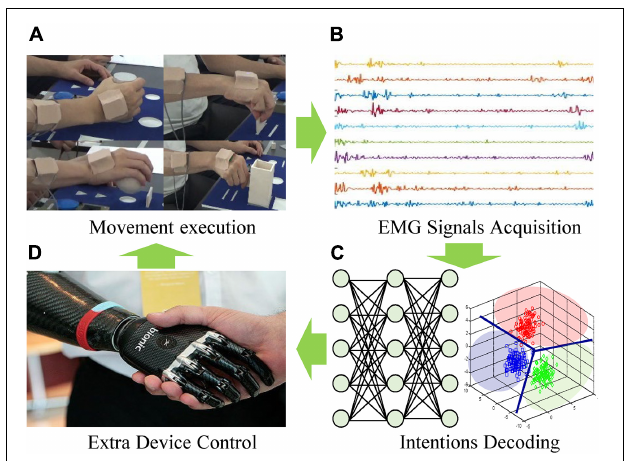
FIGURE 1 | Overview of myoelectric interfaces. (A) Movement excution. (B) EMG signals acquisition. (C) Intentions decoding. (D) Extra device